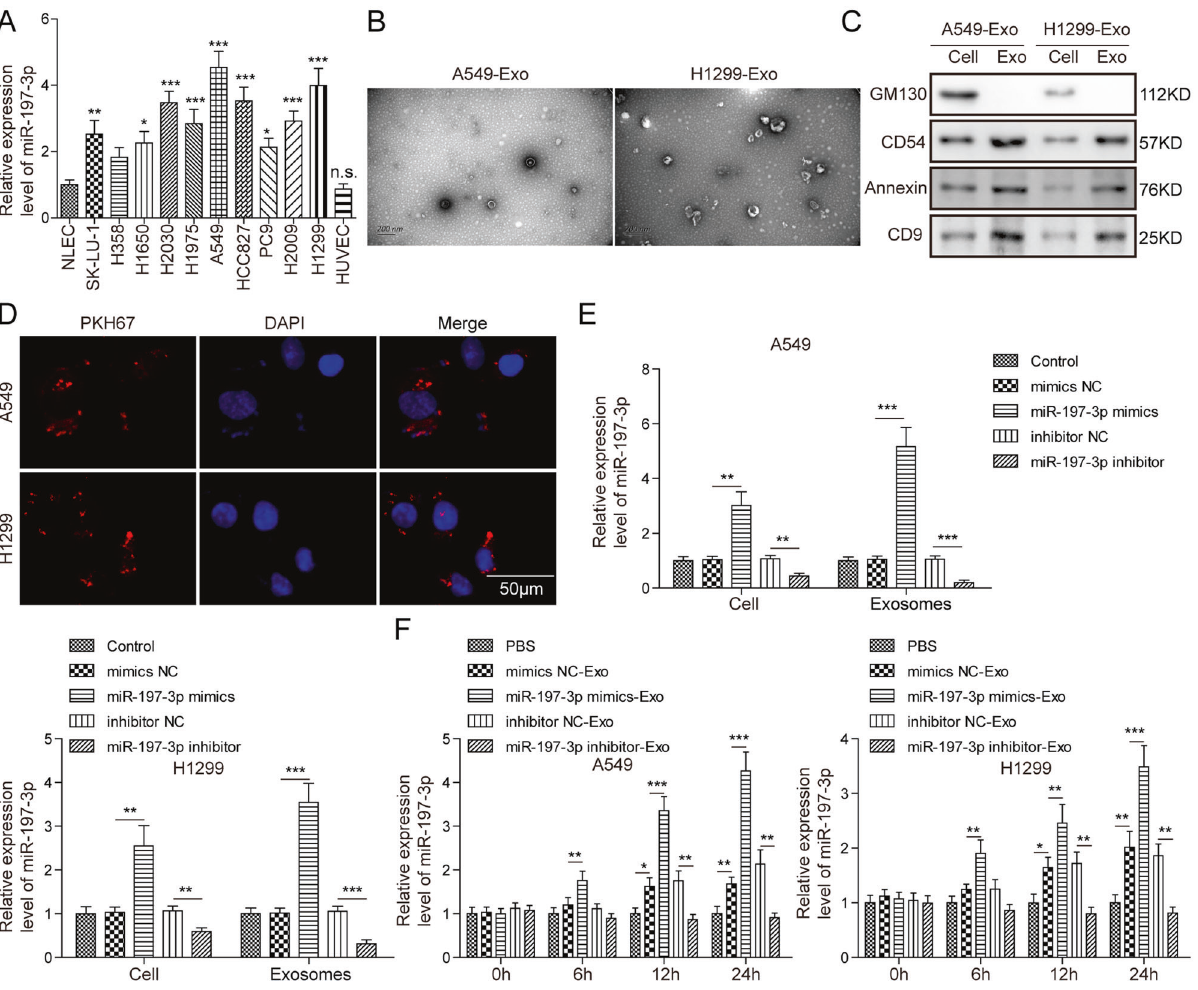
Fig. 2 Exosomes transport miR-197-3p from LUAD cells to HUVECs in vitro. A The miR-197-3p level in NLEC, LUAD cells and HUVECs was detected by qRT-PCR. B The morphologies of A549 or H1299 cells-derived exosomes were observed by TEM. C Exosome markers and negative control GM130 were detected by western blot. D The uptake of PKH26-labeled exosomes was examined by confocal microscopy. Red: PKH26; Blue: DAPI. E Cellular and exosomal miR-197-3p levels in A549 and H1299 cells were detected by qRT-PCR. F HUVECs were treated with A549 or H1299 cells-derived exosomes for 0, 6, 12 and 24 h. MiR-197-3p level in HUVECs was detected by qRT-PCR. Data were representative images or were expressed as the mean ± SD of n = 3 experiments. * P < 0.05, ** P < 0.01, *** P <